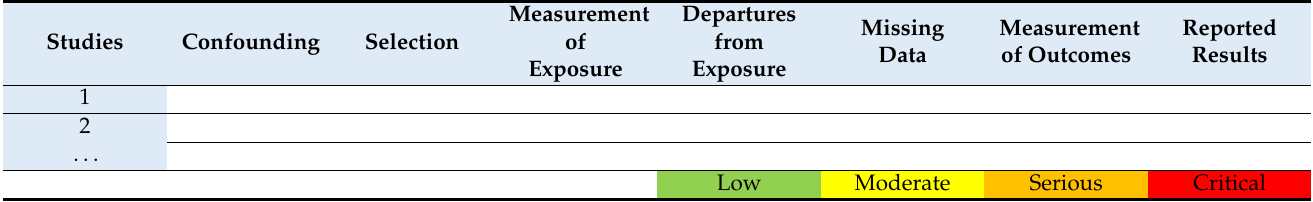
Table 1. Risk of Bias